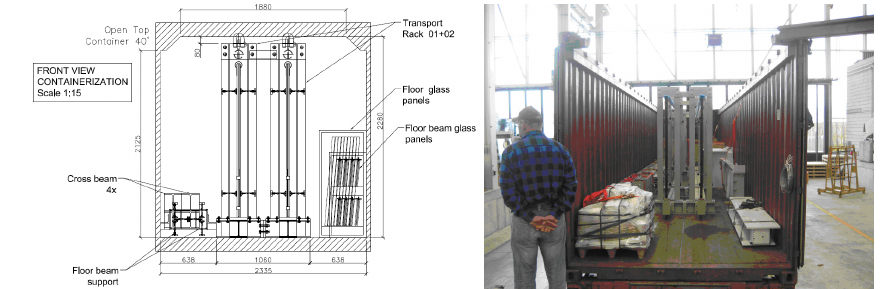
Figure 10: Transportation of the steel and glass elements